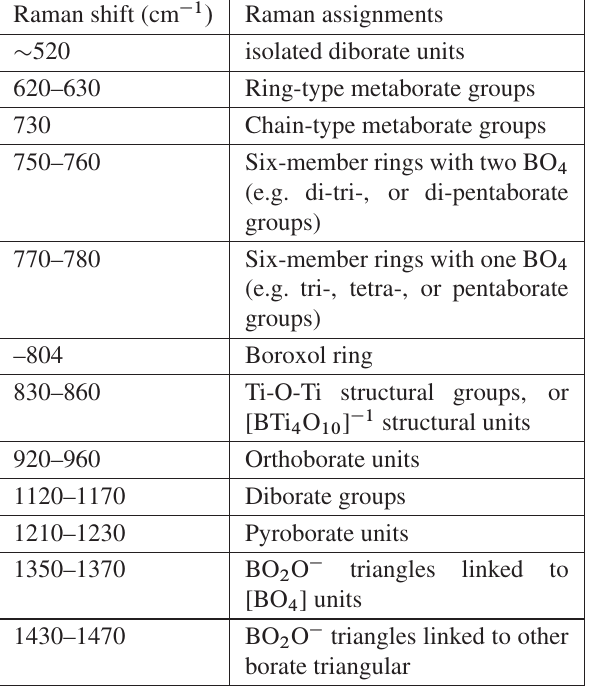
Table 2. Assignments of Raman bands in spectra of CaO- B 2 O 3 -TiO 2 glass